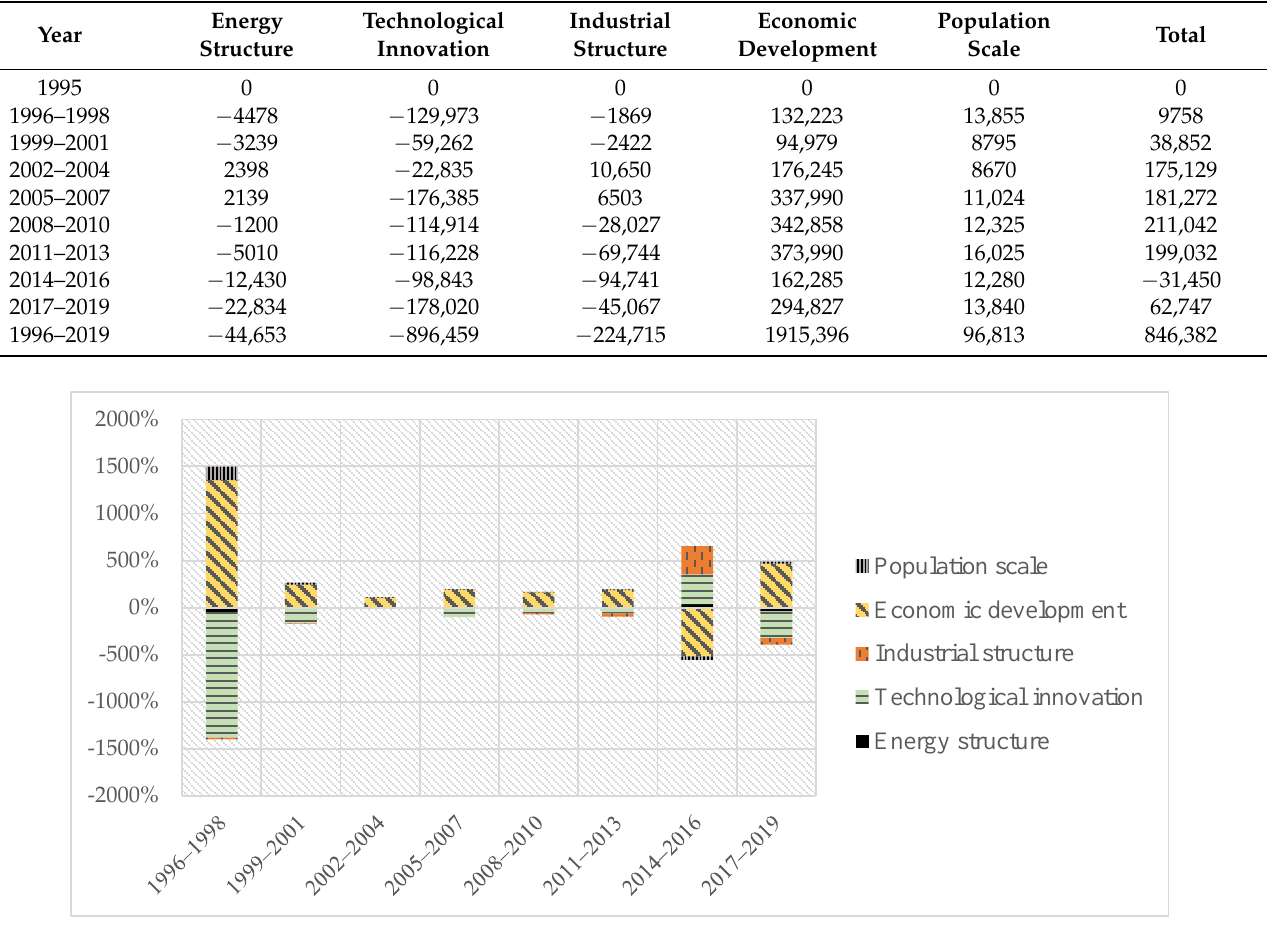
Table 2. Calculation results of China’s carbon emission factor analysis from 1995 to 2019.